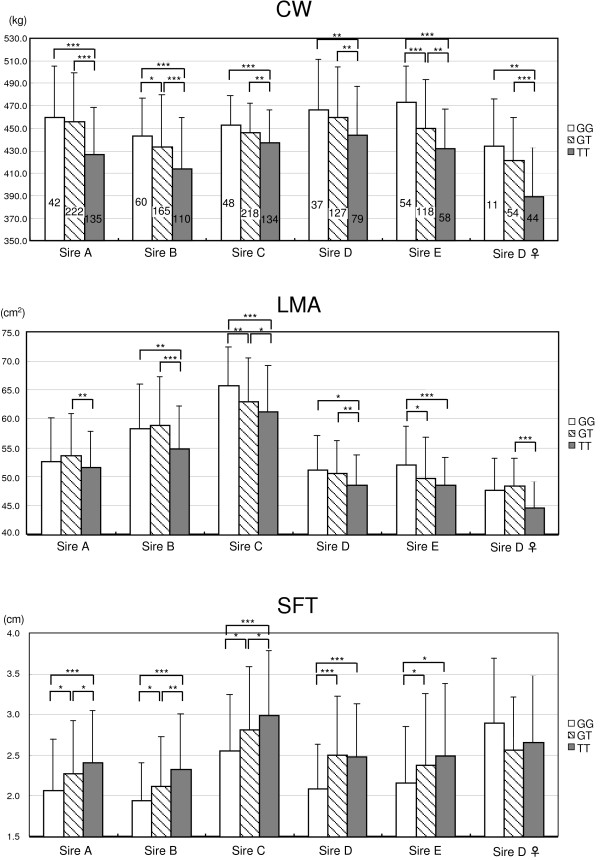
Association of the SNP-9 genotypes of NCAPG with carcass weight, LMA, and SFT. The steers of the five families and the cows of Sire D's family were genotyped with SNP-9. The number of offspring of each genotype is shown in the bar of the upper panel. The averages of slaughter year- and age-adjusted phenotypic values were compared between genotypes using a t-test. *, p < 0.05; **, p < 0.01; ***, p < 0.001.